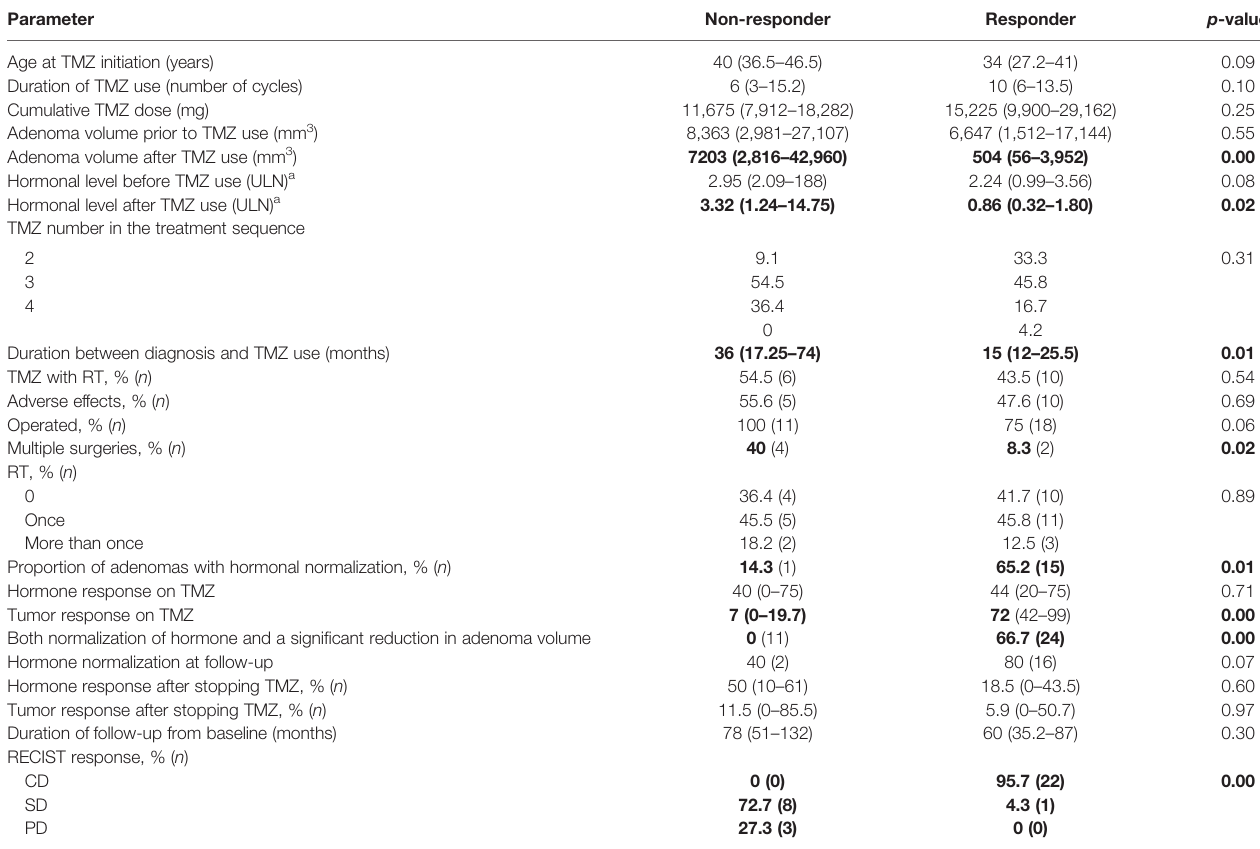
TABLE 3 | Comparative parameters between responders and non-responders with respect to course and outcomes of temozolomide therapy.